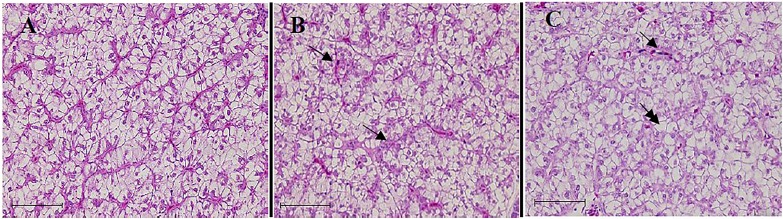
Liver histopathology of juvenile barramundi fed on TH diets without or with fermentation for 56 days.(A) Control group: the hexagonal hepatocyte with predominantly glycogen vacuoles. (B) Fish fed on TH75 diet: arrows indicate hepatocytes containing lipid droplet and cellular degeneration. (C) Fish fed on FTH75 diet: arrow indicates necrotic foci and double arrow indicates nucleus disappearance in hepatic cells (H & E staining 400× magnification, scale bar = 50 µm).